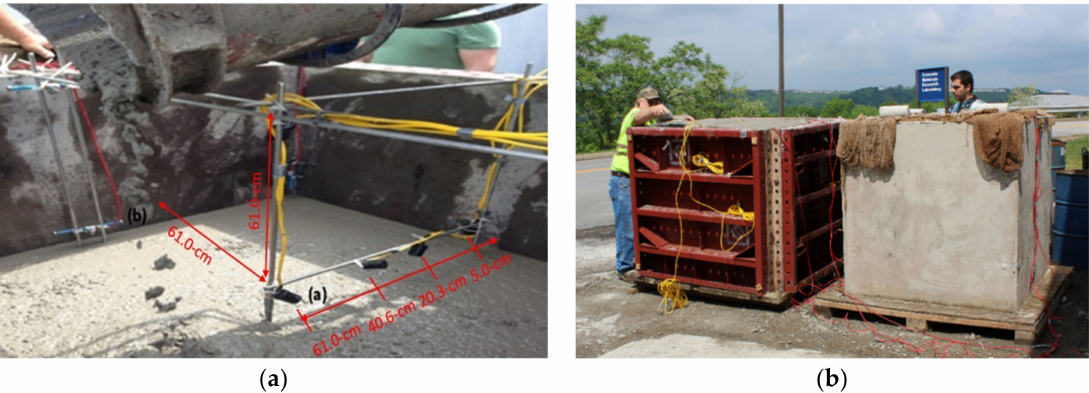
Figure 5. The picture was taken during Batch 2: ( a ) Temperature loggers and ( b ) 1.2-m Cube casting.